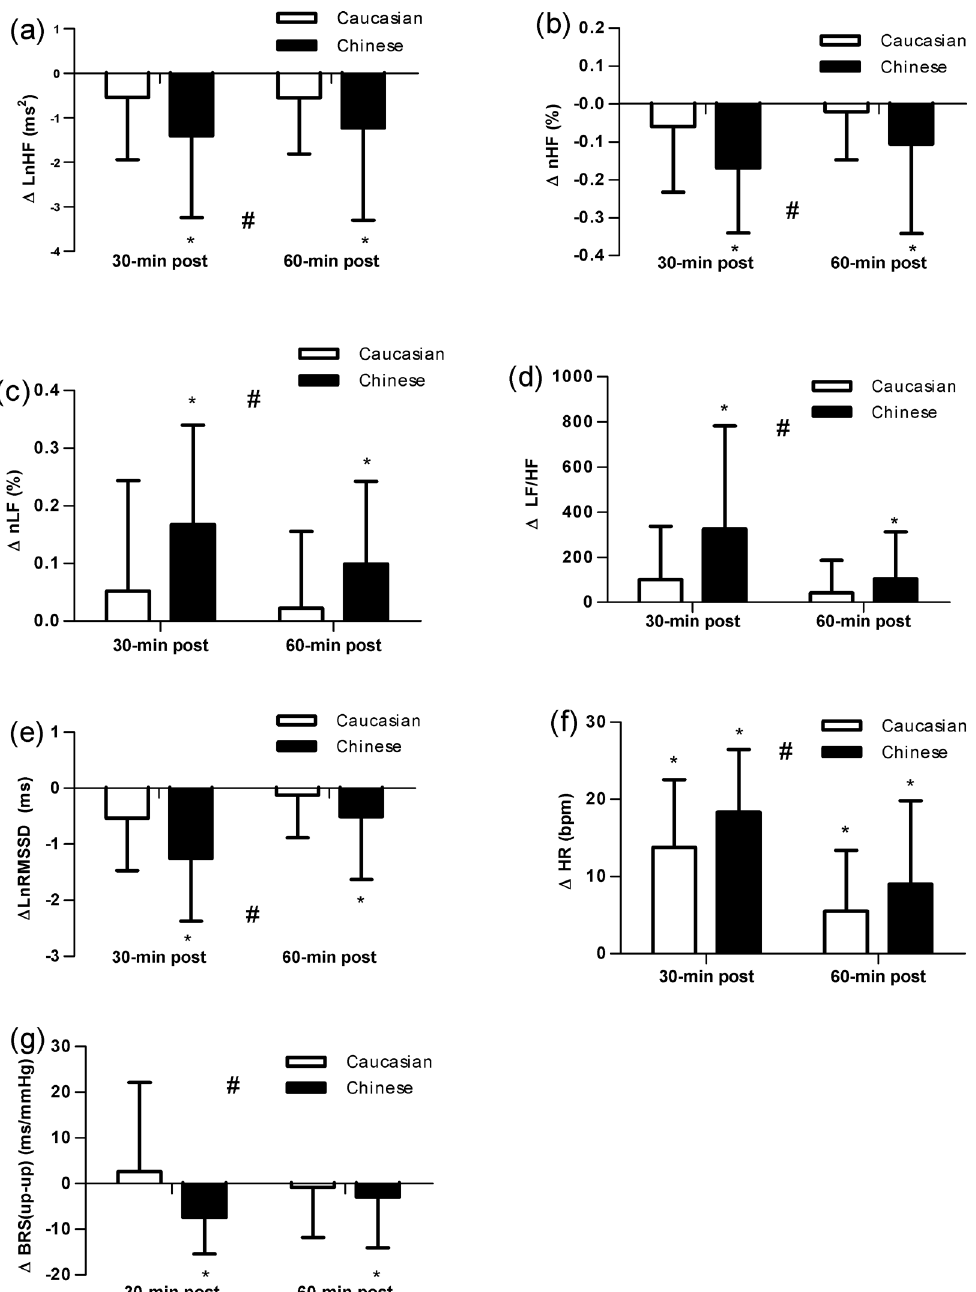
Fig 2. Change value from baseline for (a) LnHF, natural logarithm of high frequency (b) nHF, normalized high frequency (c) nLF, normalized low frequency (d) LF/HF, LF/ HF ratio (e) LnRMSSD, natural logarithm of RMSSD (f) HR, heart rate (g) BRS(up-up), Baroreflex sensitivity up-up, at 30-min and 60-min after exercise. Data are reported as mean ± SE (#significant race-by-time interaction; * significant change compared with